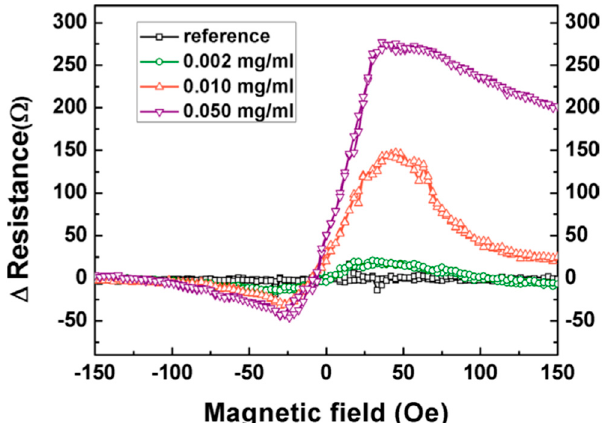
Figure 10. Resistance change of MTJ sensor after binding with three different concentrations of alpha-fetoprotein (AFP) antigens [114]. Reprinted with permission from AIP Publishing 2012.